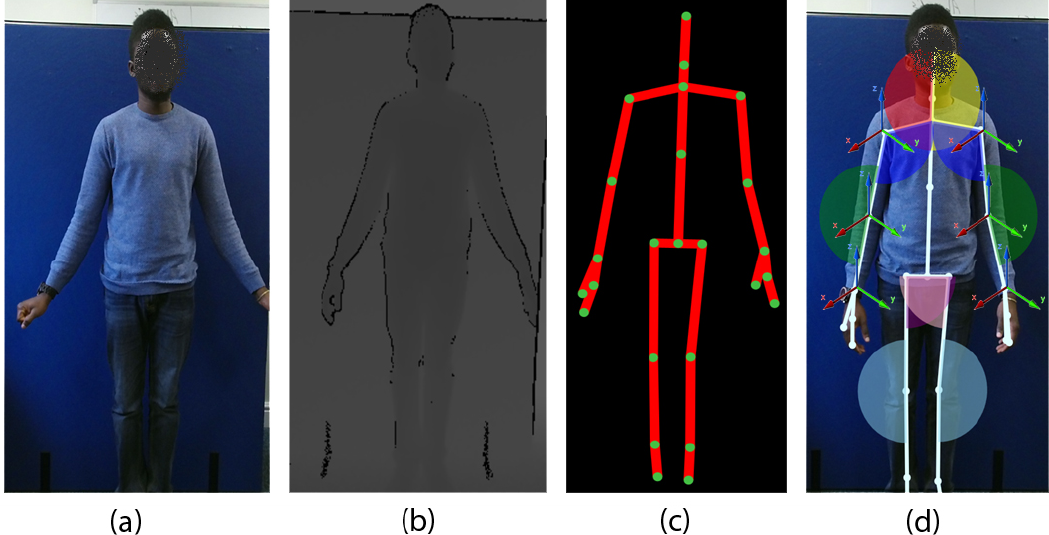
Figure 4. Illustration of depth image transformation: ( a ) colour stream; ( b ) depth stream; ( c ) skeleton (joint are shown in green dots); and ( d ) tracked skeleton and joints (similar joints are presented with the same